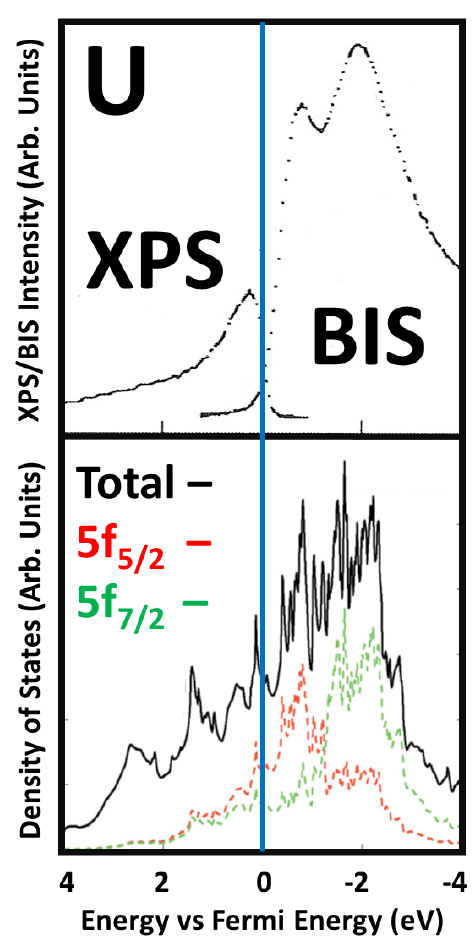
Figure 2. Here are shown results for metallic α -U. Upper panel: XPS and BIS results of Baer and Lang [14] from the Naegele review [15] Lower panel: Theory results from Kutepov [8,16,17]. E F is the Fermi energy (0 eV), shown as a blue vertical line. The occupied (unoccupied) densities of states, ODOS (UDOS), are at energies greater (less) than zero. The fine DOS structure seen in the theory (lower panel) is not seen in the experimental data (upper panel) due to experimental energy resolution limits. Note the two major lobes in both the BIS and UDOS, corresponding to the 5f 5/2 and 5f 7/2 manifolds. The Fermi energy is at zero eV.